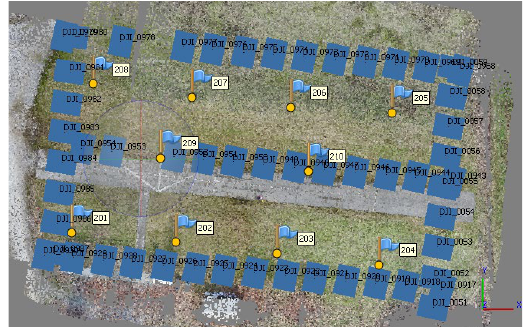
Figure 9. Acquisition geometry of Block G: just 3 E-W stripes were used (with a transversal overlap of 20%), but 2 N-S stripes were used to constrain the block